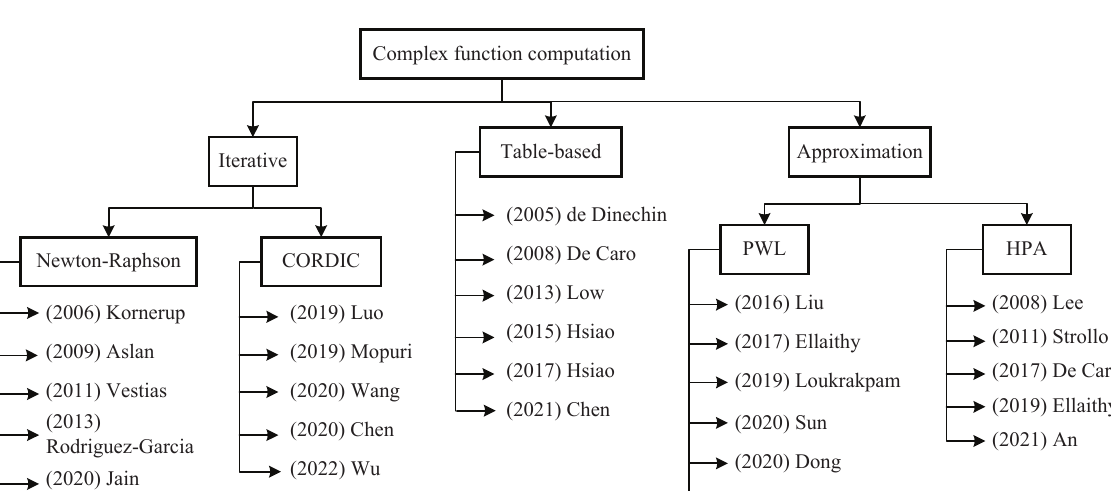
Figure 1. Taxonomy of related works on complex function